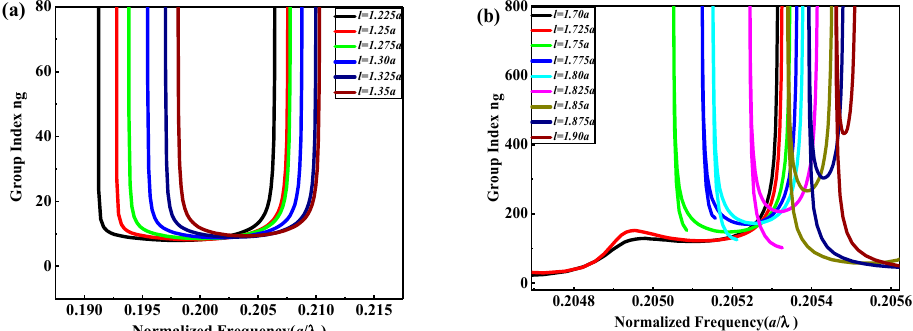
Figure 3. The group index ( n g ) versus normalized frequency a/ λ with changing defect length l for ( a ) S 1 and ( b ) S 2 .